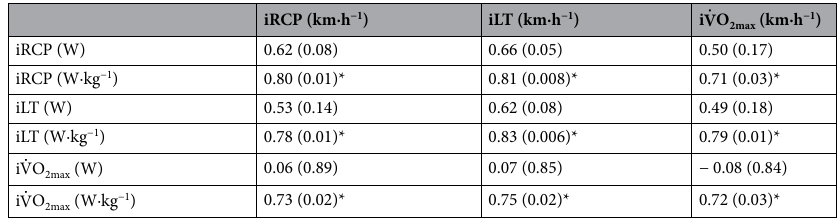
Table 1. Correlations between intensity parameters measured on the nonmotorized treadmill and motorized treadmill, expressed as r(p). iRCP metabolic threshold intensity determined by respiratory parameters, iLT ˙ V metabolic threshold intensity determined by lactate; i O 2max maximal oxygen consumption intensity. *p <